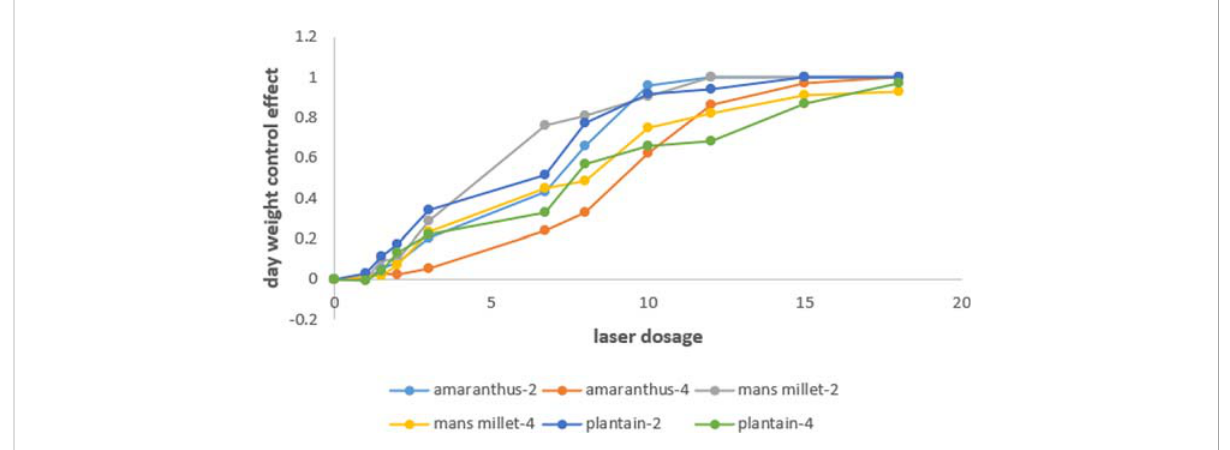
FIGURE 13 Effect diagram of laser irradiation dry